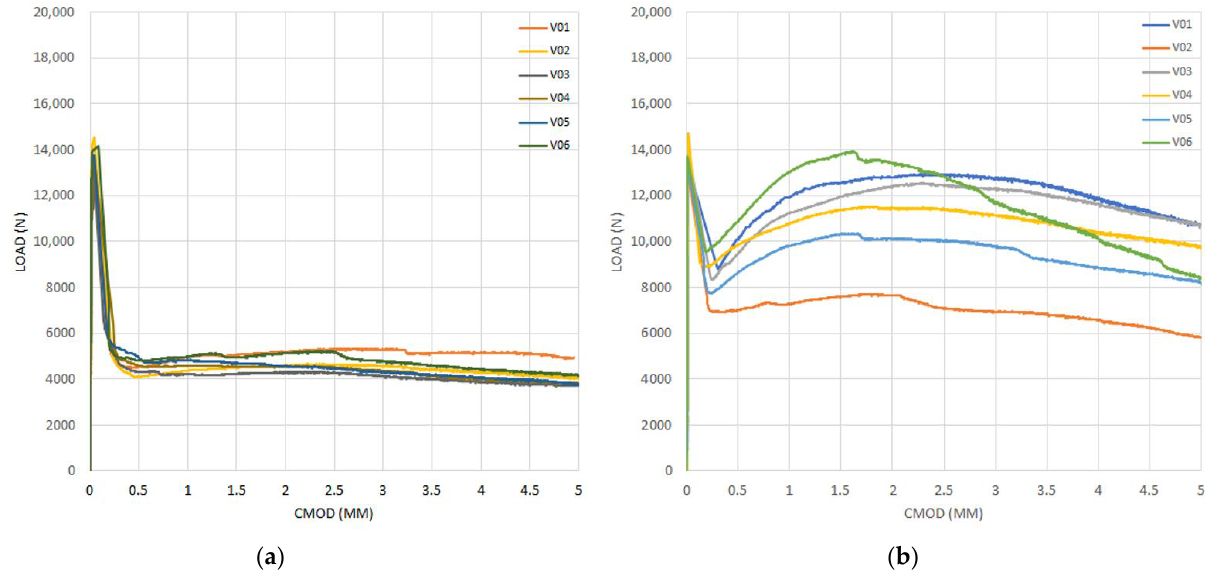
Figure 7. Curves of bending tensile test for the ratio (a/d) = 0.16, ( a ) Series 1, ( b ) Series 2.